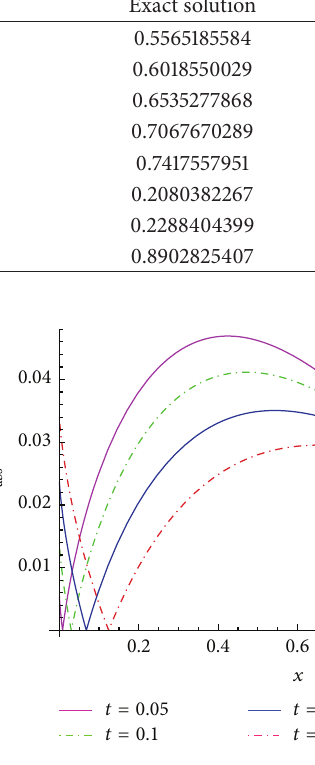
Figure 2: Plots of the absolute error 𝑢